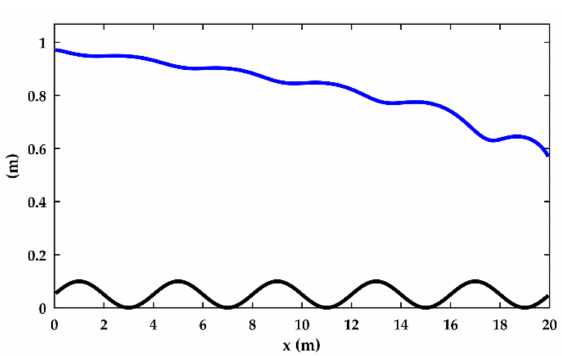
Figure 6. Hydraulic solution for test 1.